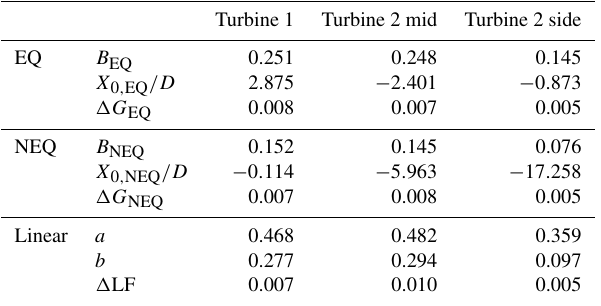
Table 4. Fit parameters and RMS errors for the different models predicting the evolution of δ for the three